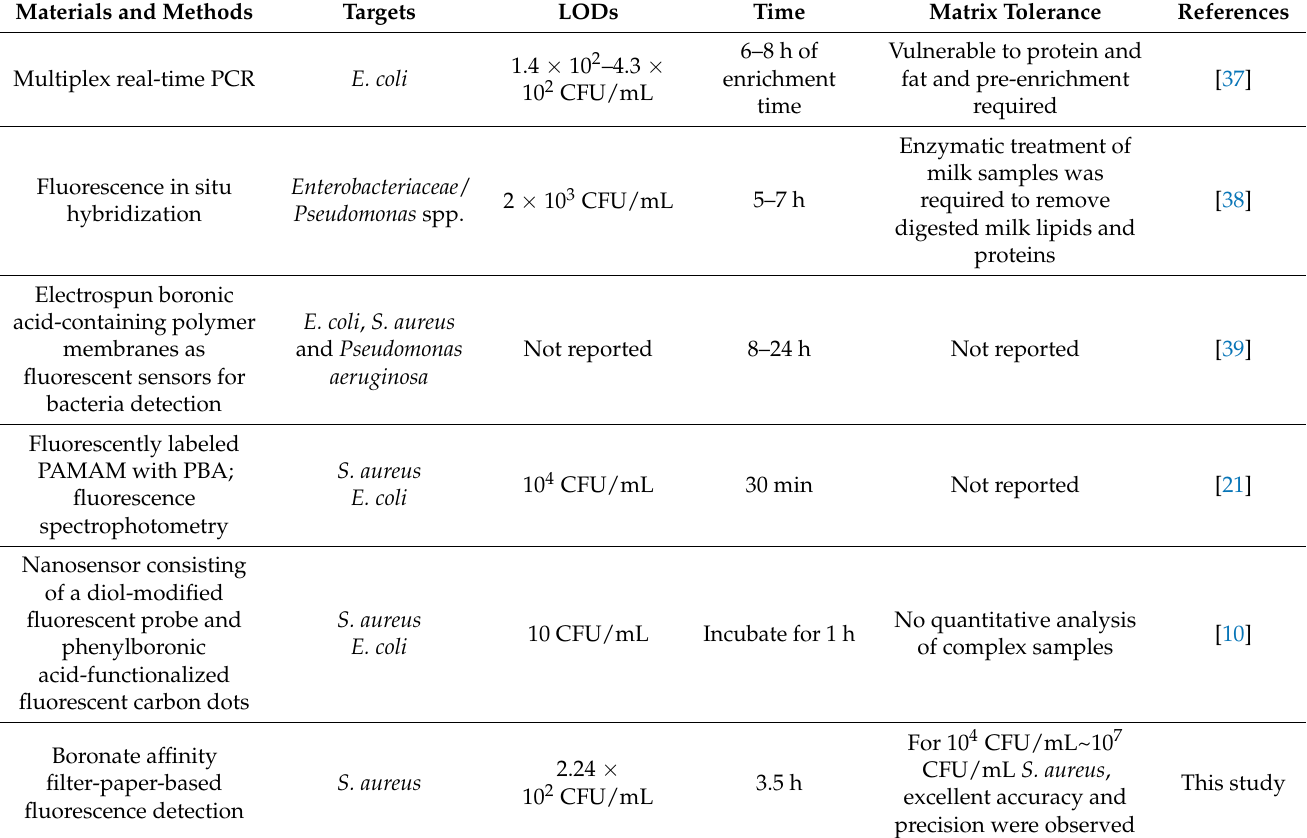
Table 1. Comparison of different fluorescent detection methods for pathogenic